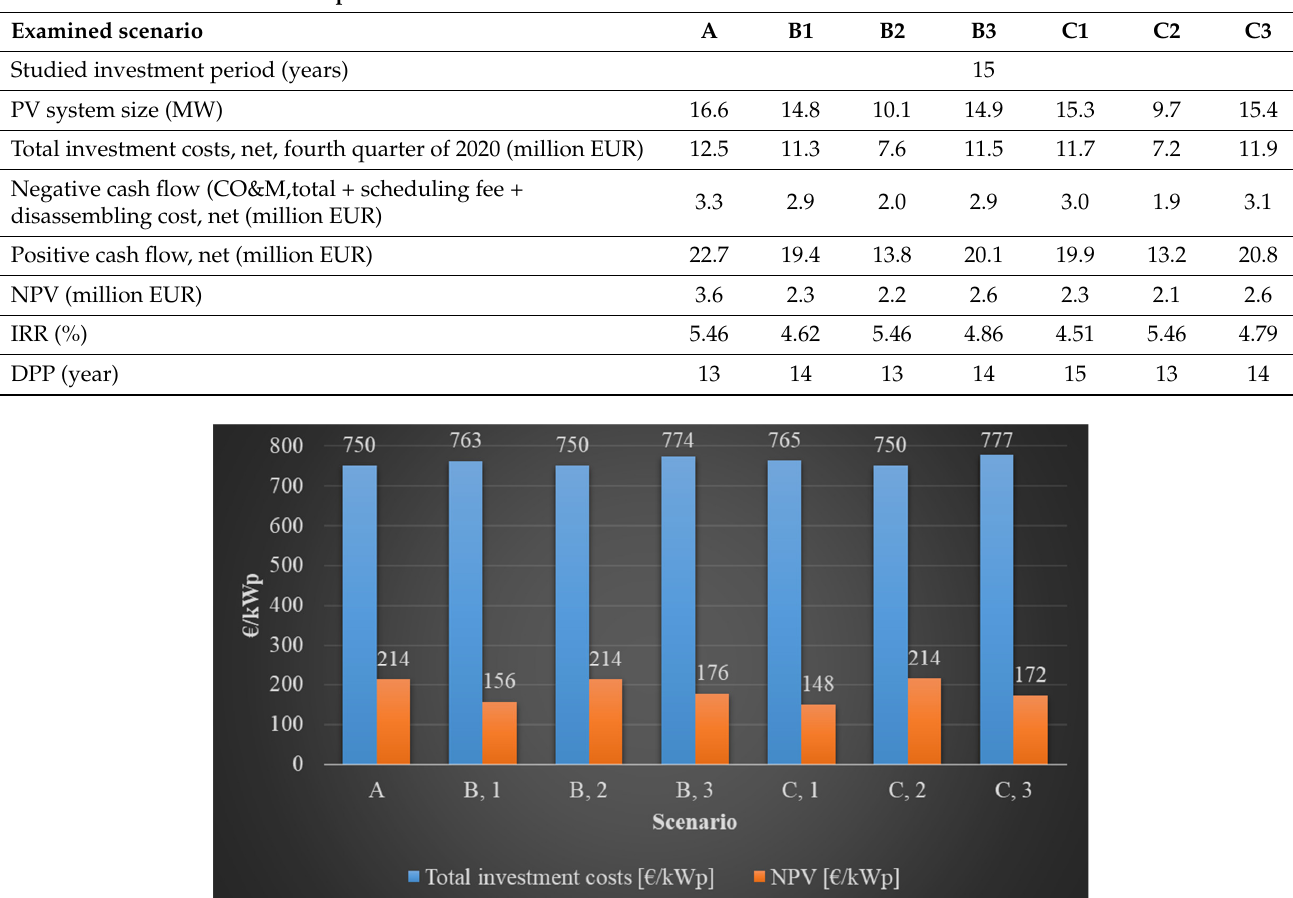
Table 7. The overall investment efficiency indices for the examined scenarios.